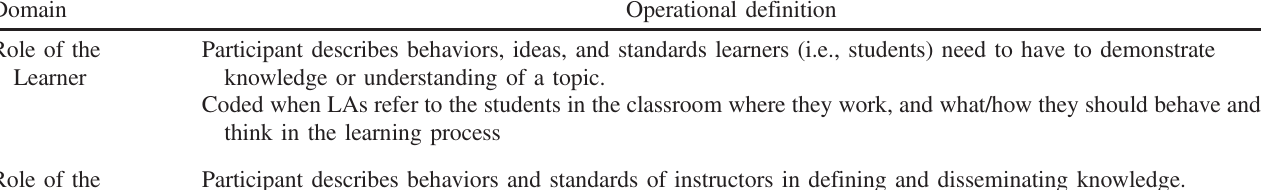
TABLE IV. Overview of domains within the epistemological reflection model. Domain Operational definition Role of the